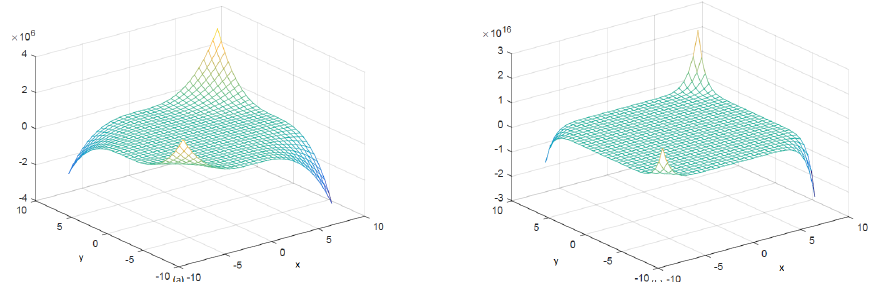
Figure 15: Plotting of (a) M-polynomial and (b) NM-polynomial of Podophyllo-